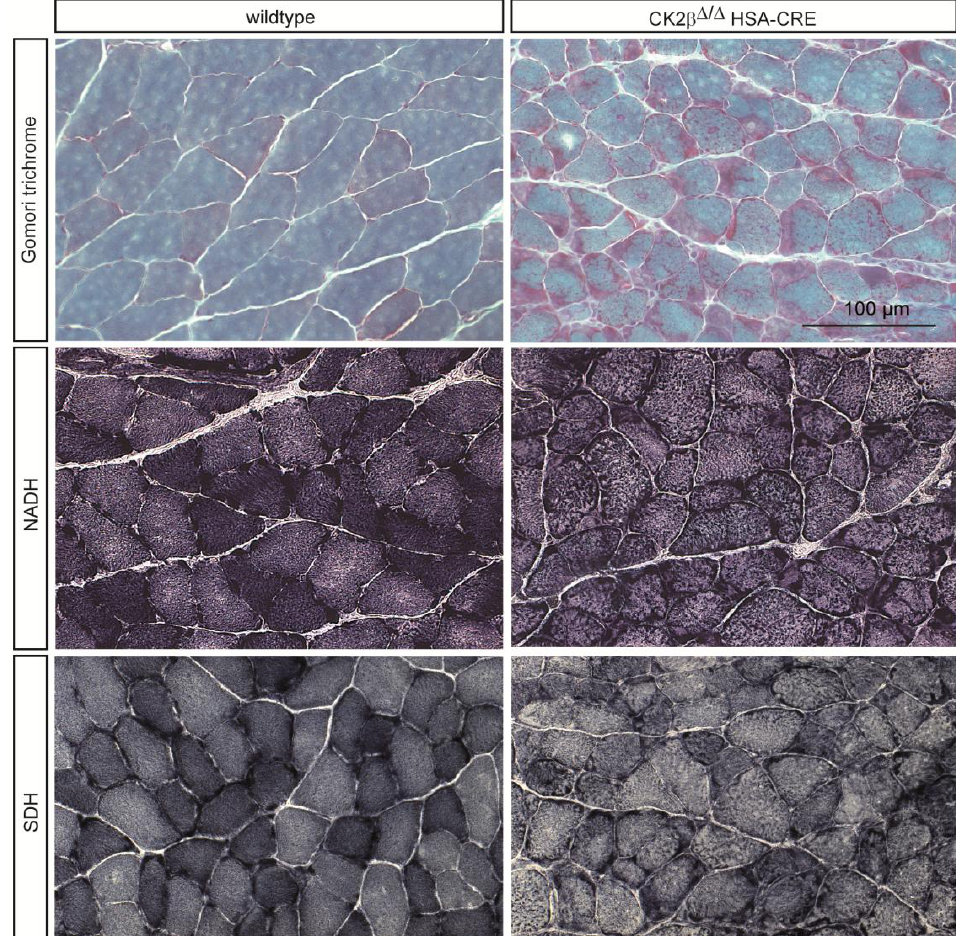
Figure 3. High-resolution images of hind limb cross sections after different histochemical stainings show soleus muscles of wildtype and CK2β-deficient mice. Note that, in comparison with wildtype controls, cross sections of CK2β-deficient muscle fibers are of more granular appearance after NADH dehydrogenase and SDH staining, and there are a significant number of fibers with lower diameter. The scale bar shown is representative for all images of muscle cross-sections.